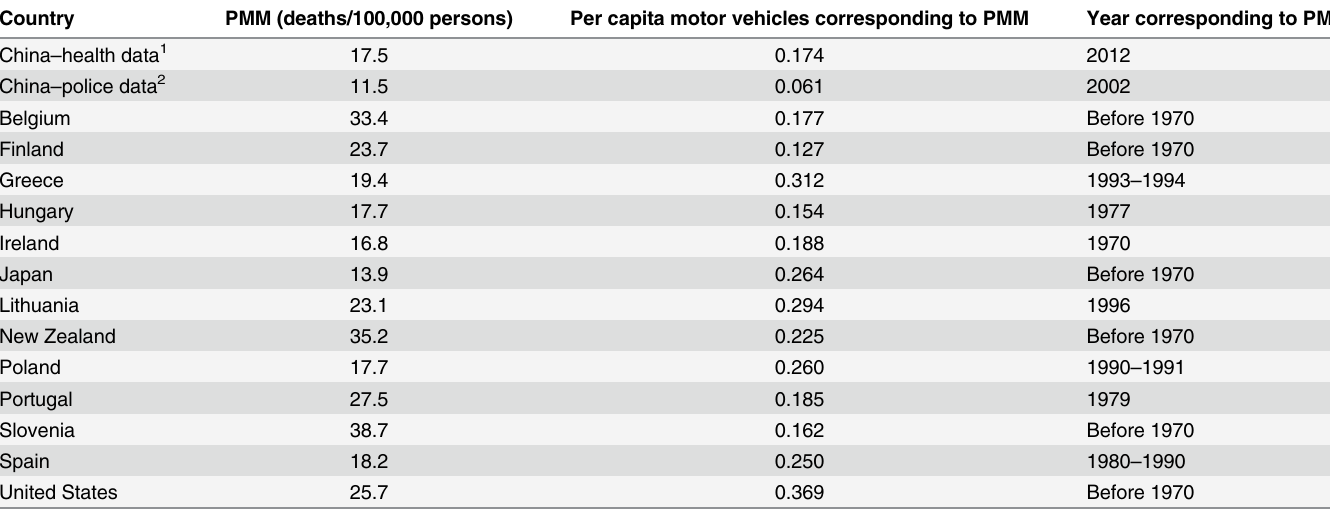
Table 2. Key results based on the simulation of modified Smeed equation using data from China and 13 selected